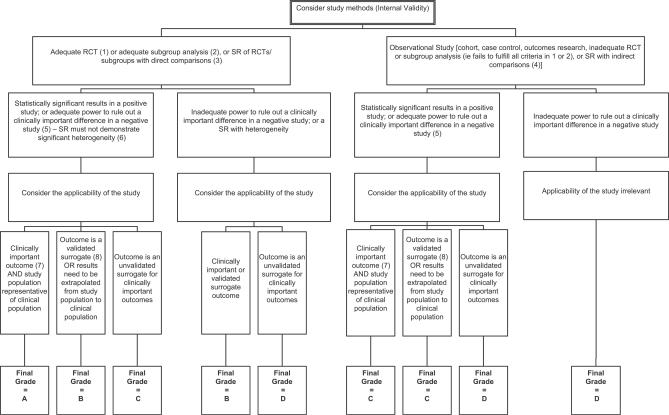
The Evidence-Grading Scheme Employed in this StudyAdapted from CHEP [9].An “adequate” RCT is one with allocation concealment, blinded assessment of outcomes (if subjective), intention-to-treat analysis, adequate follow-up (i.e., at least 90%, or losses to follow-up are too few to materially affect the results), and sufficient sample size to detect a clinically important difference with power > 80% (1). Subgroup analysis was a priori, done within an adequate RCT, one of only a few tested, and there was sufficient sample size within the examined subgroup to detect a clinically important difference with power > 80% (2). A sytematic review (SR) with direct comparisons is one in which the comparison arms are derived from head-to-head comparisons within the same RCT (3). A systematic review with indirect comparisons is one in which the comparison arms are derived from different RCTs, then extrapolations are made across RCTs (4). Adequate power in a negative study implies that the 95% confidence interval excludes a clinically important difference (5). Effect estimates in each study included in the systematic review are qualitatively similar (i.e., in the same direction) (6). Clinically important outcomes are “hard” endpoints such as death, stroke, or myocardial infarction (7). End points have been consistently shown to be associated with the clinical end point in multiple studies (observational or RCT), and RCTs have consistently demonstrated that improvement in the surrogate translates into a consistent and predictable improvement in the clinical end point (8).